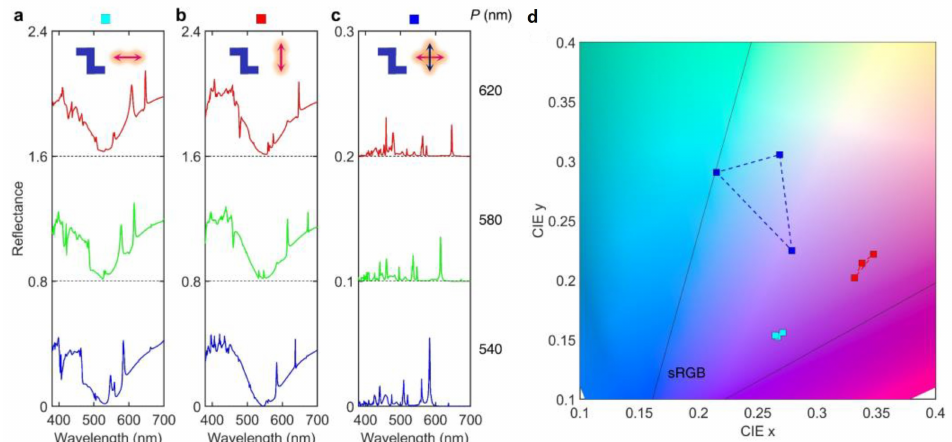
Figure 5. The color performance of embedded chiral metasurface with different P from 540 nm to 620 nm. The reflectance spectra under ( a ) single‑polarization with 0 degrees to the x‑axis, ( b ) single‑ polarization with 90 degrees with 90 degrees to the x‑axis, ( c ) cross‑polarization at different p from 540 nm to 620 nm. ( d ) The corresponding CIE 1931 chromaticity diagram of ( a – c